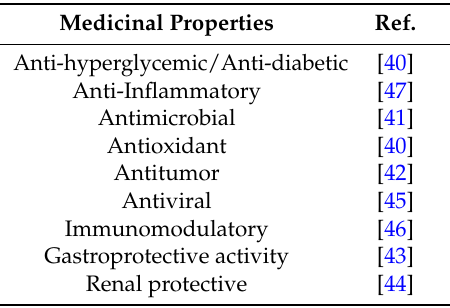
Table 3. Medicinal uses of Stevia species. Medicinal Properties